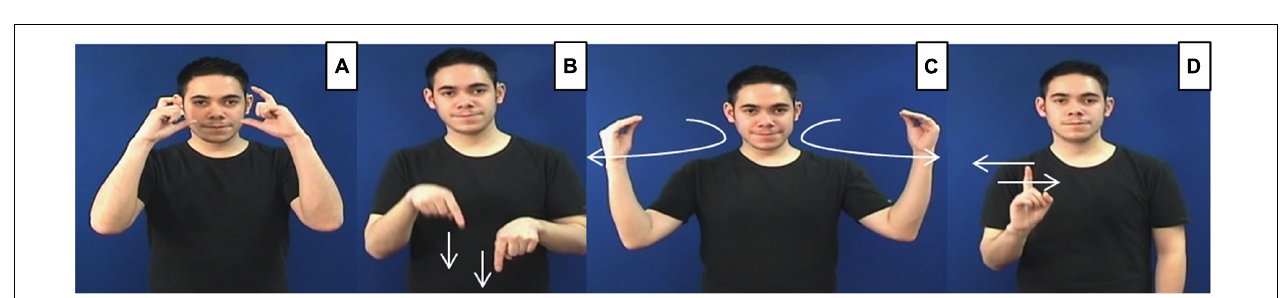
FIGURE 2 | Lexical signs PLANE in BSL (A) , American Sign Language (B) , and Korean Sign Language (C) . The three languages represent iconically the fuselage of a plane but they use distinct phonological handshapes.